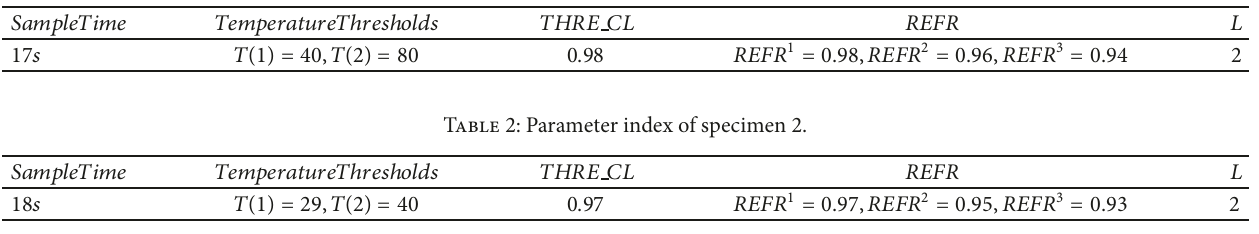
Figure 13: The normalized mixing vector 1, mixing vector 2, mixing vector 3, mixing vector 4, and 𝑇𝑇𝑅 1 , 𝑇𝑇𝑅 2 , 𝑇𝑇𝑅 3 , and 𝑇𝑇𝑅 4 . Table 1: Parameter index of specimen 1.